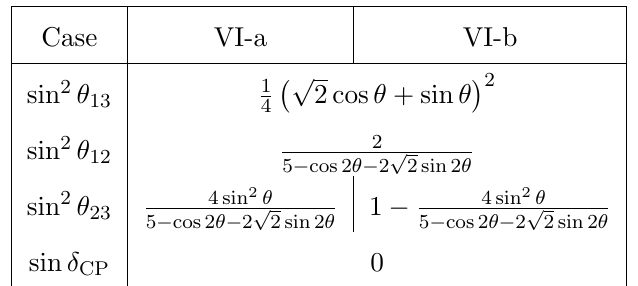
Table 2 . Predictions for the leptonic mixing parameters in terms of the free parameter (cid:18) in the case originating from G CP = S 4 o CP broken to G e = Z 4 (or Z 2 in ref.